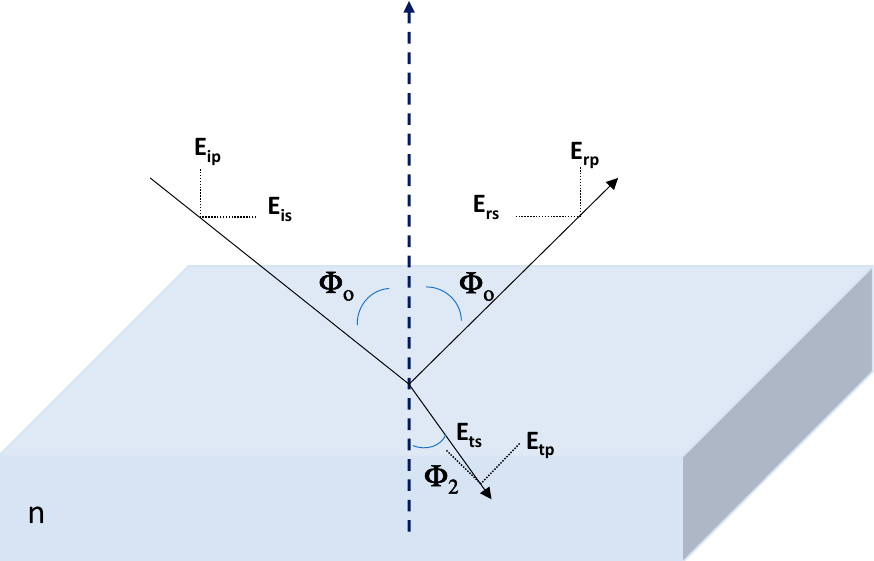
Figure 3. Scheme of spectroscopy ellipsometry measurement for a homogeneous sample. Φ o incident angle; Φ 2 : refraction angle. E is : perpendicular component of the incident electric field; E ip : parallel component of the incident electric field; E rs : perpendicular component of the reflected electric field; E rp : parallel component of the reflected electric field; E ts : perpendicular component of the refracted electric field; E tp : parallel component of the refracted electric field. Sample refraction index: